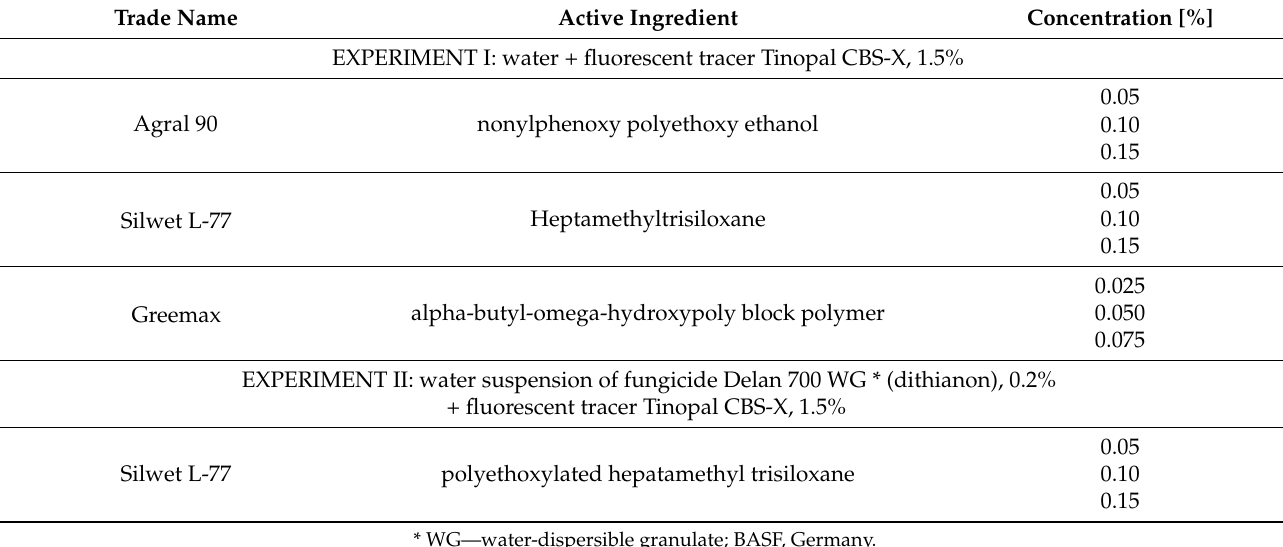
Table 1. Adjuvants used in experiments on their effect on spray coverage and droplet density on apple leaves. Trade